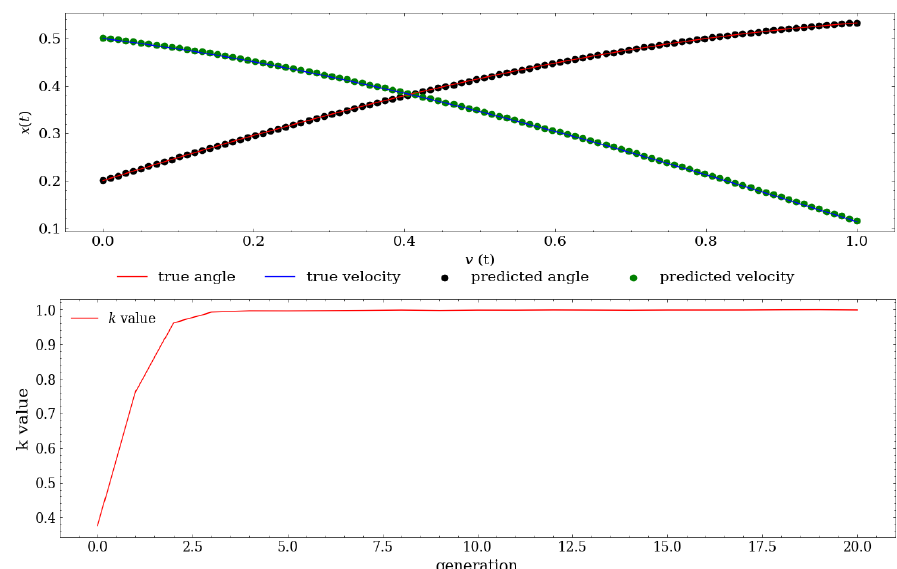
Figure 4. Inverse pendulum problem: the top figure shows the comparison between the true value with the predicted value from PINN trained by NSGA-PINN method. The figure on the bottom shows the prediction of constant value k .